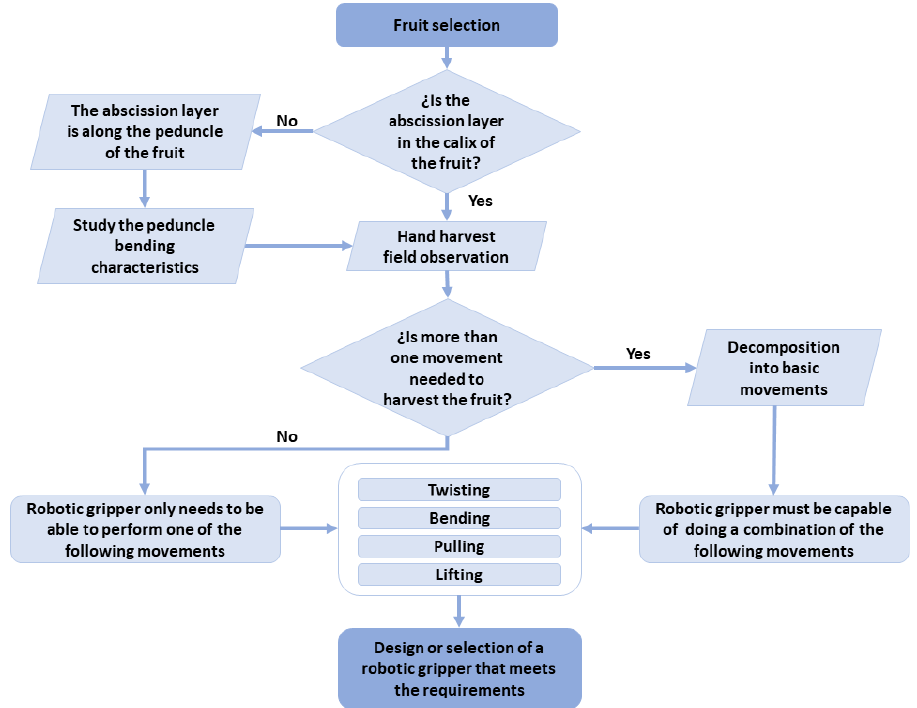
Figure 3. Steps to design or select a gripper or end-effector based on the study of a picking